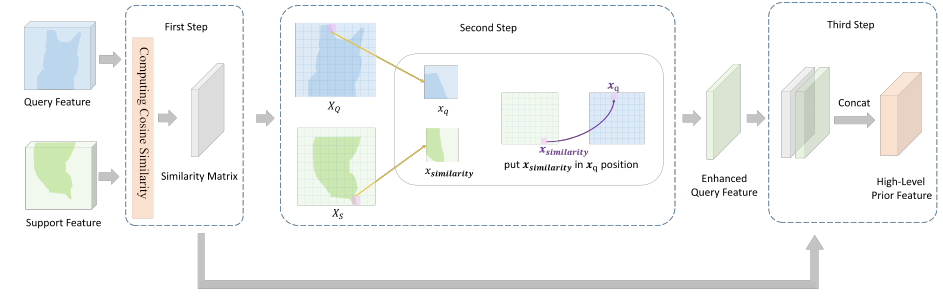
Figure 3. Overview of our prior feature-matching network with the query feature enhancement module and multi-scale feature matching module. Blue arrows, circled M, and circled + represent the feature matching, inter-scale merging, and concatenation, respectively. The activation functions are ReLU. PFMNet takes an episode, i.e., the support-query image pair, as input. Based on the mid- and high-level backbone features, the query feature enhance module (QFEM) and the multi-scale feature matching module (MFMM) perform feature enhancement and feature matching on the feature pairs, respectively. Finally, a concatenation, the feature enrichment module (FEM), and a convolution block followed by a classification head are used to yield the final prediction.